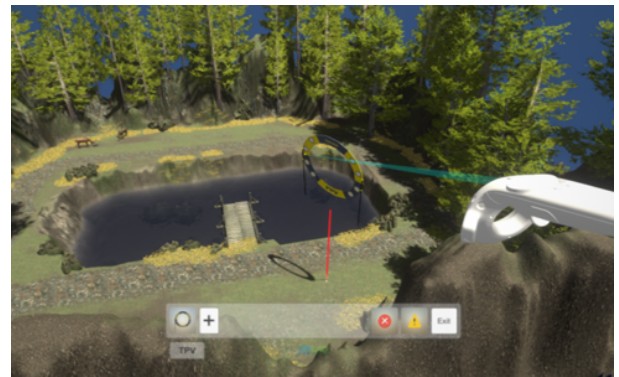
Figure 18. Auxiliary line of a virtual obstacle.